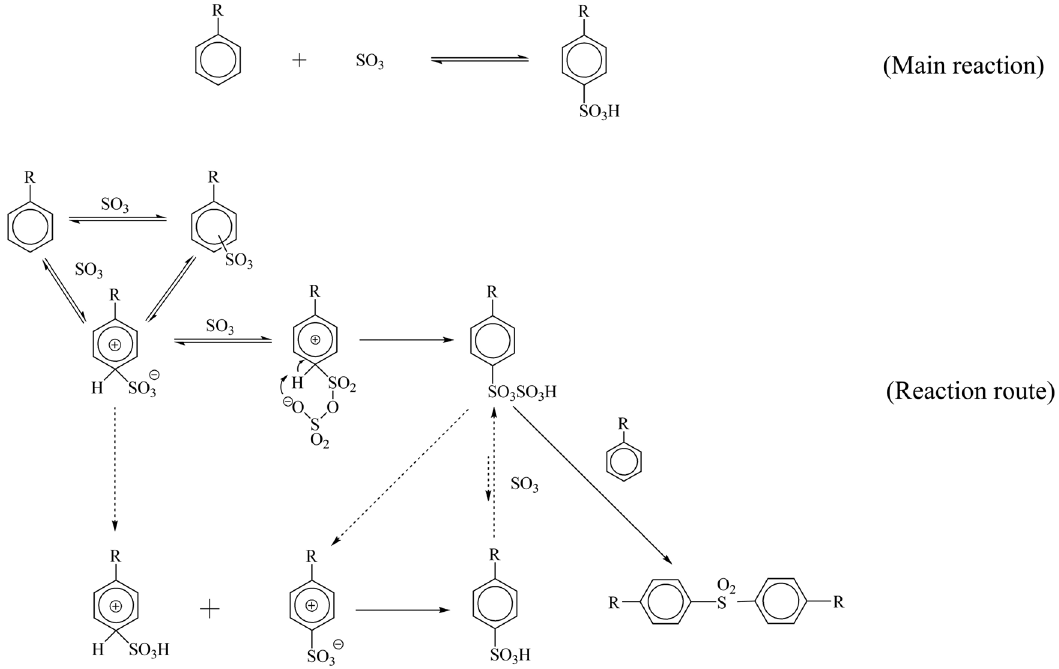
Figure 1: Mechanism of sulfonation of alkyl